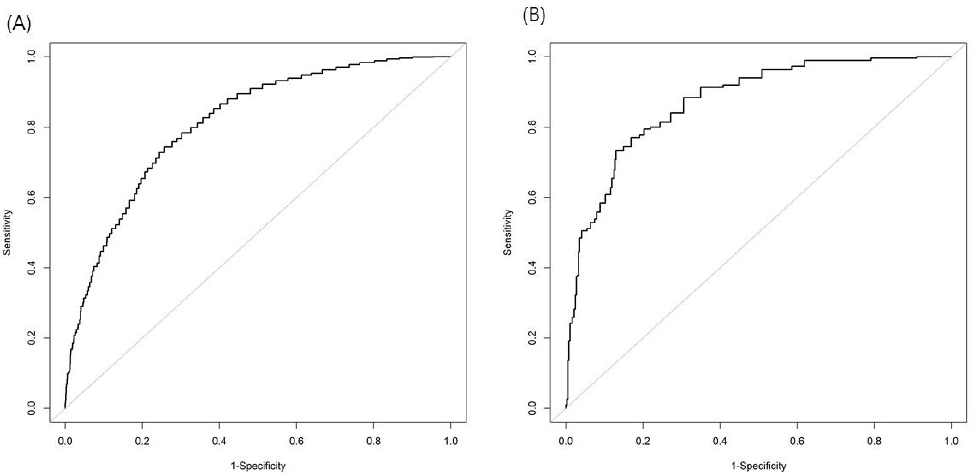
Figure 1. Area under the receiver operating characteristics curve of the fatty liver index for predicting nonalcoholic fatty liver disease in males ( A ) and females ( B ).